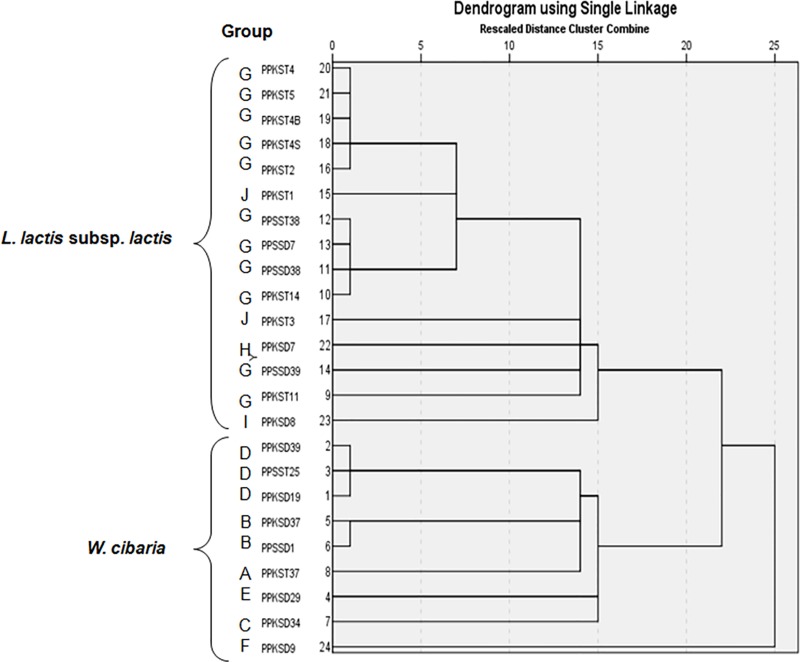
Dendrogram showing clustering and relationships of 24 potential isolates used in the study based on API 50 CH fermentation of 49 carbohydrates.The analysis was performed by calculating the Euclidean distance and the associations of isolates were constructed using the single linkage method (Nearest neighbour) in the IBM SPSS Statistic 22.0.